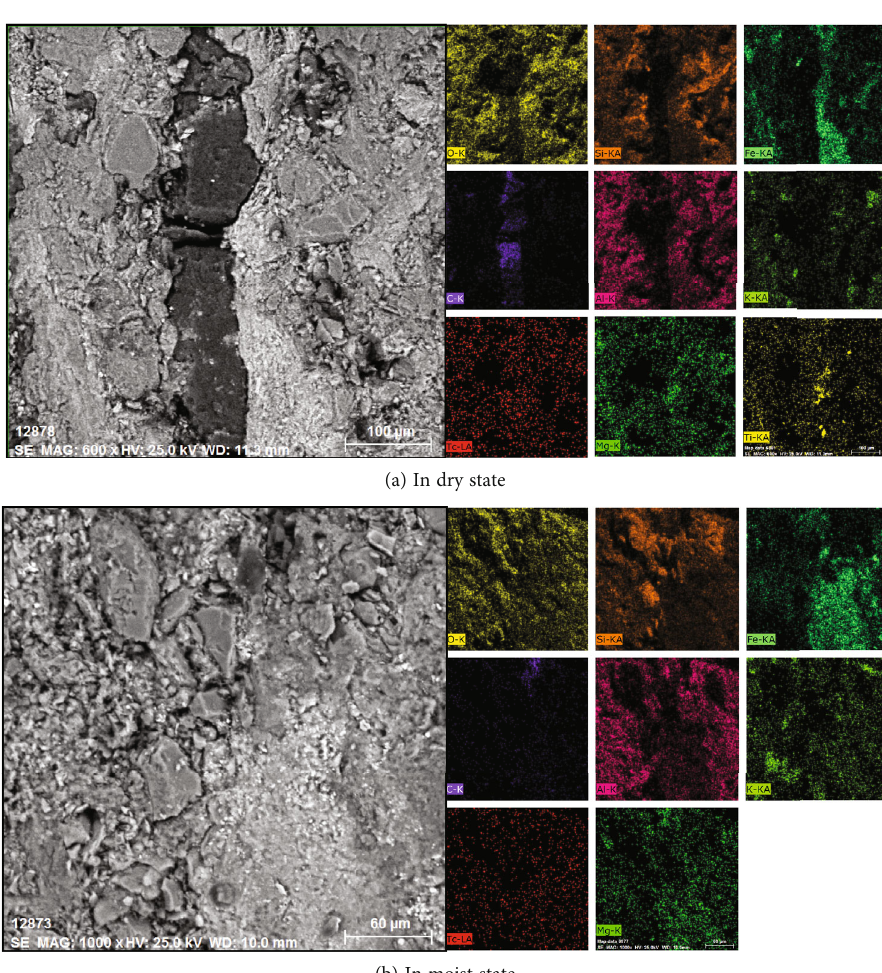
Figure 6: Mapping area and element distribution of mudstone in the dry state and moist state. Table 2: Quantitative results of the main elements.